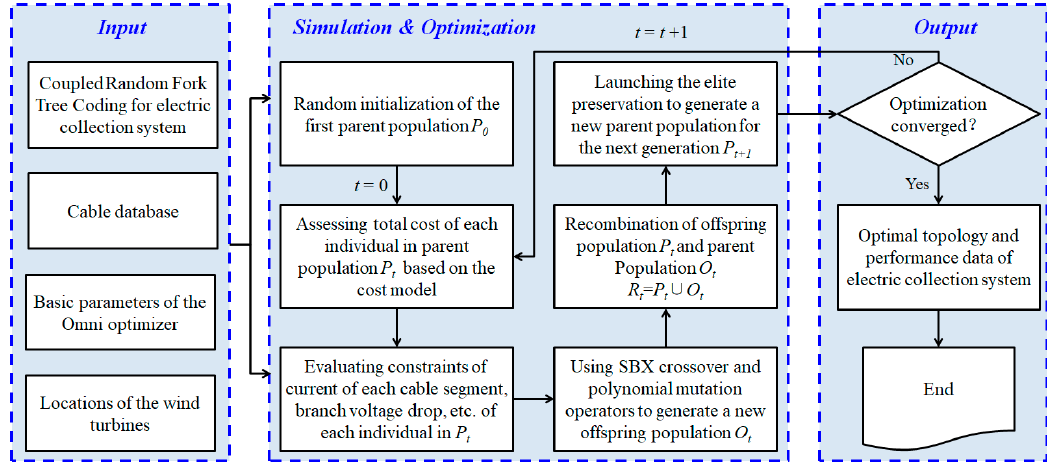
Figure 6. Integration optimization process for the wind farm power collection system.